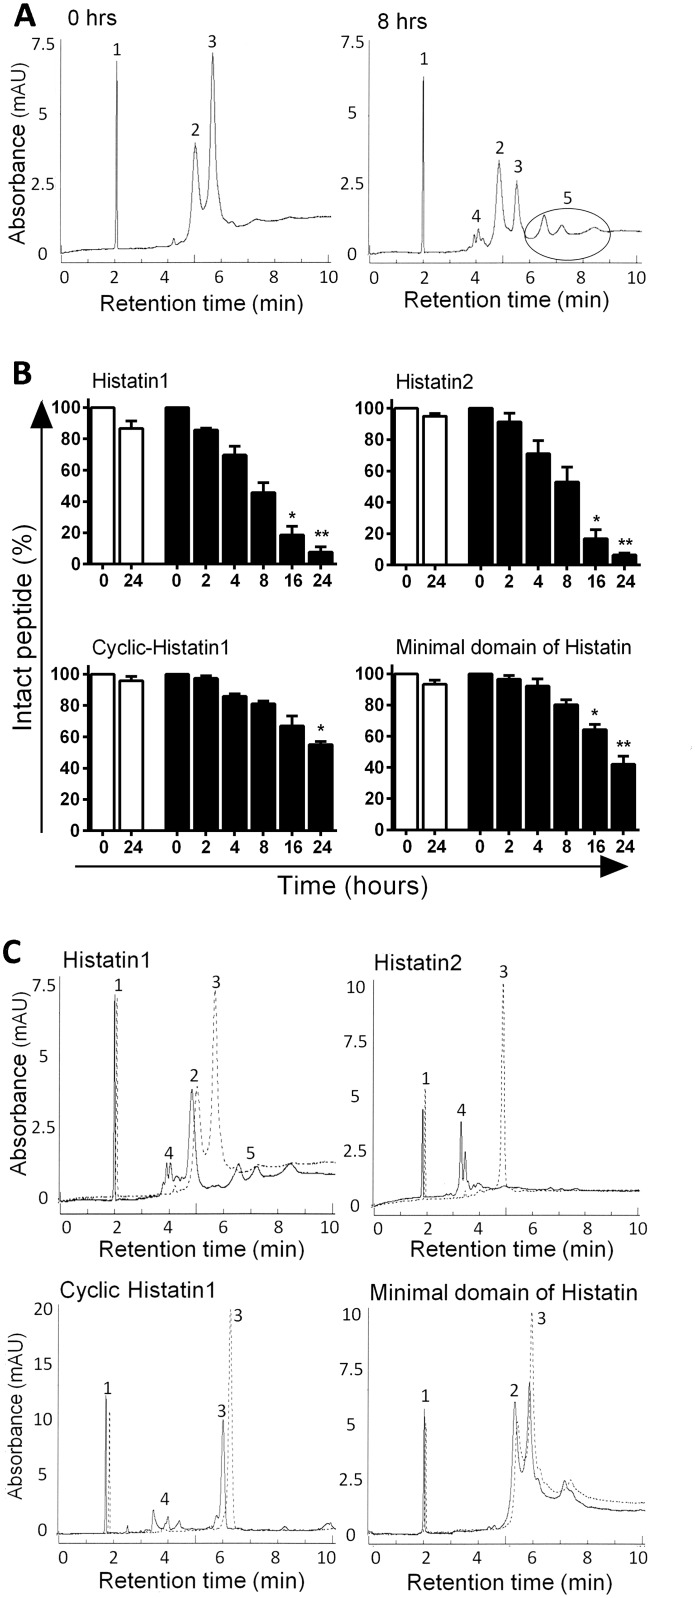
Stability of histatins during incubation with chronic wound extract.A: Capillary zone electrophoresis graph of Hst1 incubation with chronic wound extracts at 0 and 8 h. At 0 h three peaks are visible: 1 = internal standard, 2 = CWE, 3 = Intact Hst1. At 8 h two additional peaks arise, representing breakdown products of Hst1 and CWE (peak 4 and 5). B: Percentage of intact histatins after incubation with CWE, relative to the amount at the start of incubation. White bars = incubation with PBS, black bars = incubation with CWE. Bars represent means ± SEM of three independent experiments, performed with CWE pools of 5 donors. * P <0.05, ** P <0.01. C: Capillary zone electrophoresis graph of histatin incubation with CWE; dashed line = 0 h, solid line = 24 h. For a description of the peak number see legend A.